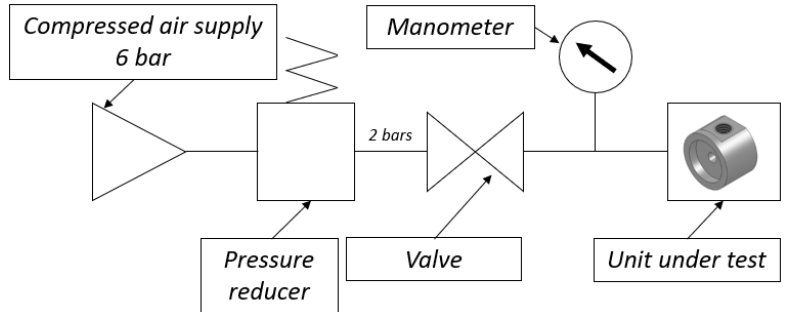
Figure 4. Conceptual diagram of the pneumatic measurement system Adapted with permission from Ref. [31], 2022, ATEQ.